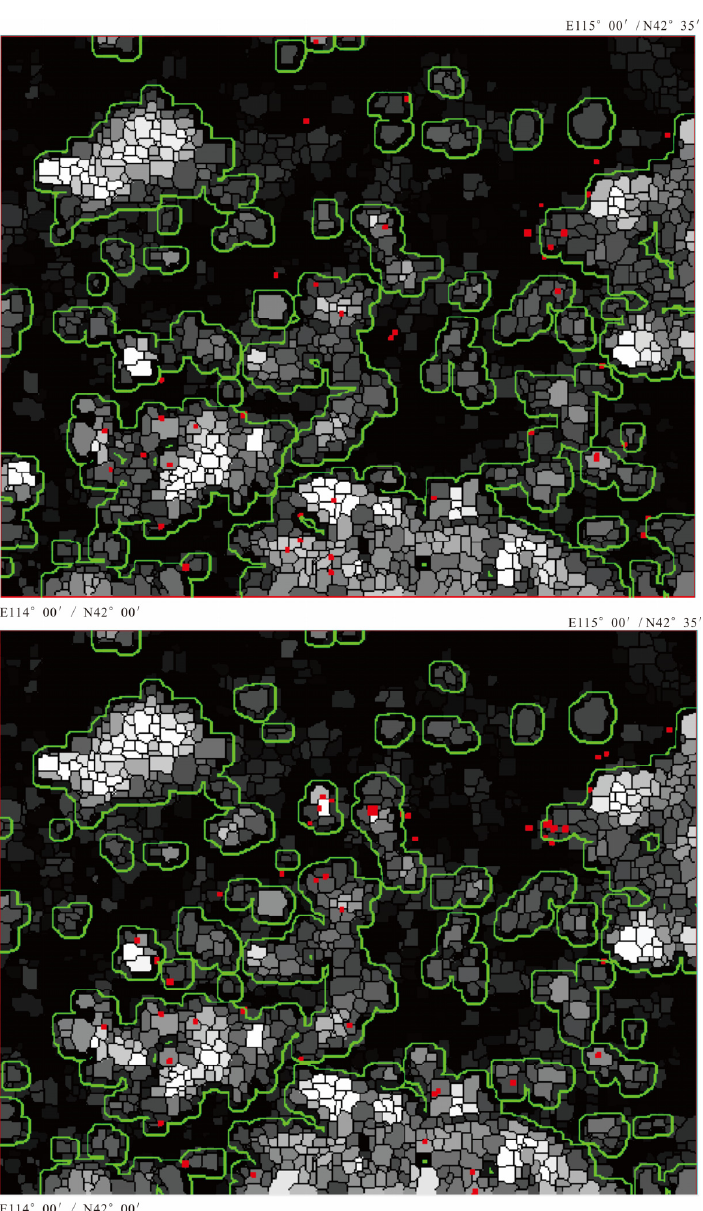
Figure 17. (upper) the object-based anomaly score map for I-series elements with relevant ore spots (red squares) overlaid on it. (lower) the object-based anomaly score map for S-series elements with relevant ore spots overlaid on it. The image objects with larger scores are represented by brighter tones, while the image objects with smaller scores are represented by darker tones. Here we set the binarization threshold as the 70th percentile value, and the regions delineated by green lines are the anomalous regions with a 3-pixel buffer zone, which account for approximately 44.375% of the total area.